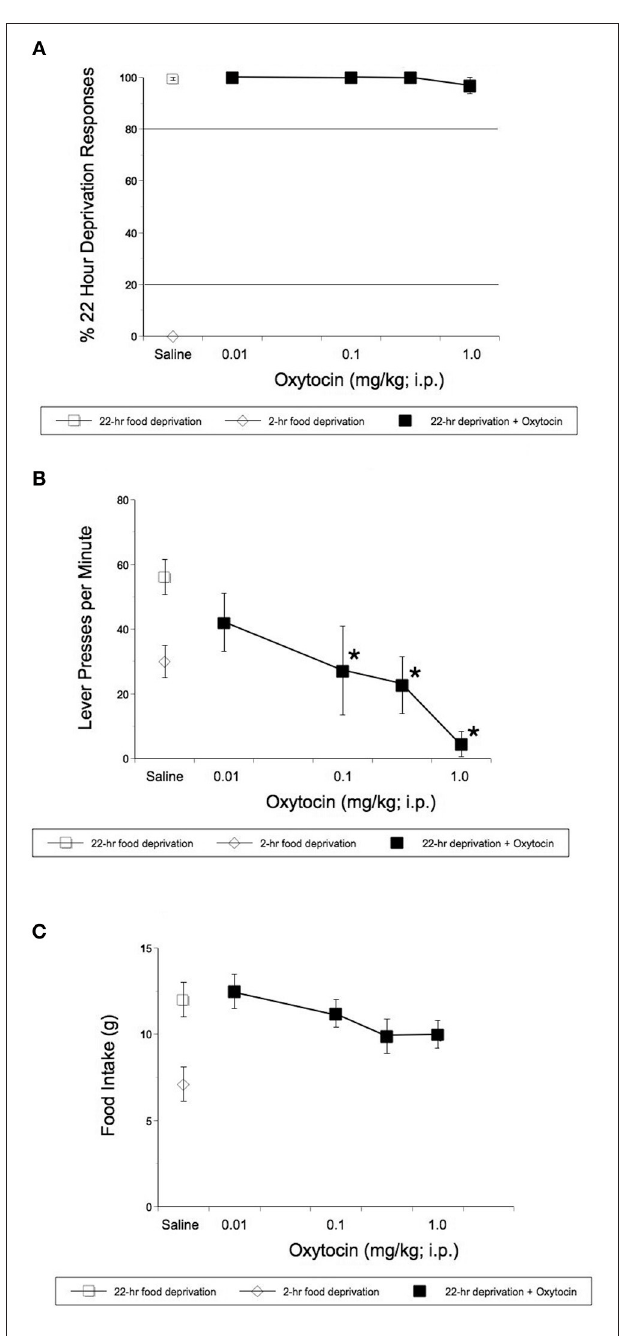
FIGURE 2 | Effect of i.p. OT on the stimulus effects of 22-h food deprivation (A) , lever pressing response rates (B) , and regular laboratory chow intake in 1h immediately following the completion of the discrimination test (C) . Animals had access to regular chow ad lib, before chow was withheld for 22h and animals were injected. Saline was the vehicle. Operant studies revealed that OT did not alter the discriminative stimulus effects of 22-h food deprivation [ F (4,16) = 1.00, p = 0.436 (A) ]. OT did significantly alter response rates in rats [ F (4,31) = 8.08, p = 0.0001 (B) ]. OT significantly reduced rates of lever pressing following 0.1 ( p = 0.044), 0.32 ( p = 0.001), and 1 mg/kg OT i.p.( p < 0.0001) (B) . (C) Shows that animals deprived for 22h and treated with OT, did not show significantly reduced consumption of regular chow in 1hr after the completion of the operant test. * p <